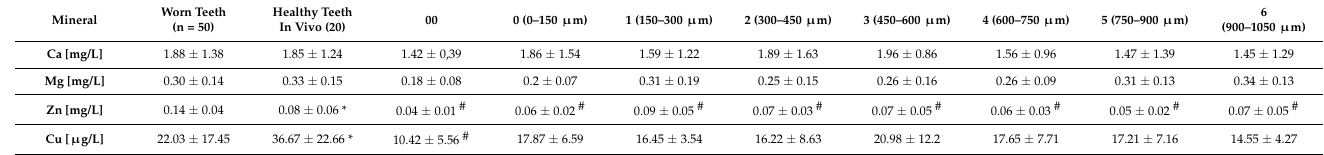
Table 1. The amounts of calcium (Ca), magnesium (Mg), zinc (Zn) and copper (Cu) in the study